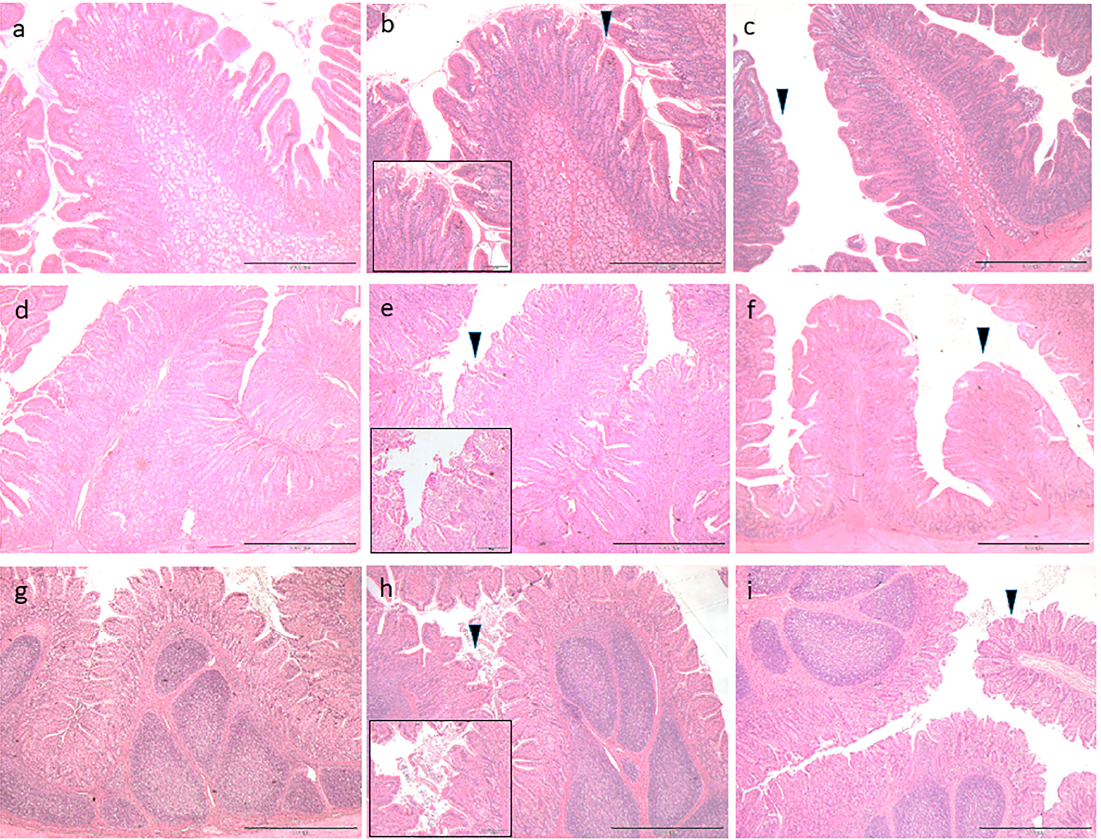
Figure 1. Histological findings of sections of the small intestine (hematoxylin eosin staining) in each group: ( a ) duodenum, control group (CTR); ( b ) duodenum, diet with 9% sunflower oil (T1); ( c